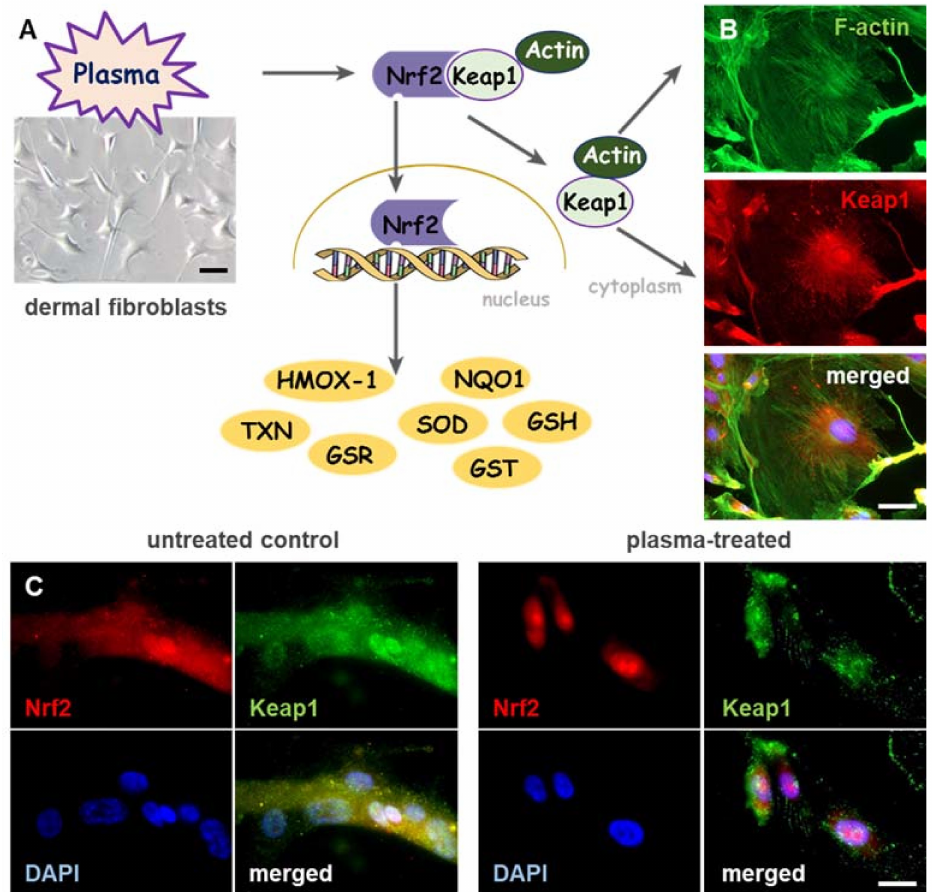
Figure 2. Cold physical plasma triggers nuclear translocation of Nrf2, and induces co-localization of Keap1 with actin filaments in the cytoplasm. ( A ) Dermal fibroblasts (bright field image, left) were isolated from SKH1 mouse skin and exposed to cold physical plasma-derived ROS/RNS. Upon nuclear translocation of the nuclear factor erythroid 2-related factor 2 (Nrf2), plasma significantly altered antioxidant and phase II detoxification enzymes and proteins (e.g., heme oxygenase 1 (HMOX-1), NADPH quinone oxidoreductase 1 (NQO1), thioredoxin (TXN), glutathione reductase (GSR), superoxide dismutase (SOD), glutathione S -transferase (GST), glutathione (GSH) etc.). ( B ) Cytoplasmic localization of Kelch-like ECH-associated protein 1 (Keap1) was detected immunohistochemically by anti-Keap1 antibody (red). Co-localization of Keap1 with actin filaments was visualized by staining with fluorescein isothiocyanate (FITC)-phalloidin (green). ( C ) Subcellular localization of Keap1 (green) and trans-localization of Nrf2 (red) from the cytoplasm to the nucleus were detected immunohistochemically by anti-Keap1 and anti-Nrf2 antibodies in plasma-treated (right panel), but not control fibroblasts (left panel). Scale bars 100 µ m ( A ), 50 µ m ( B , C